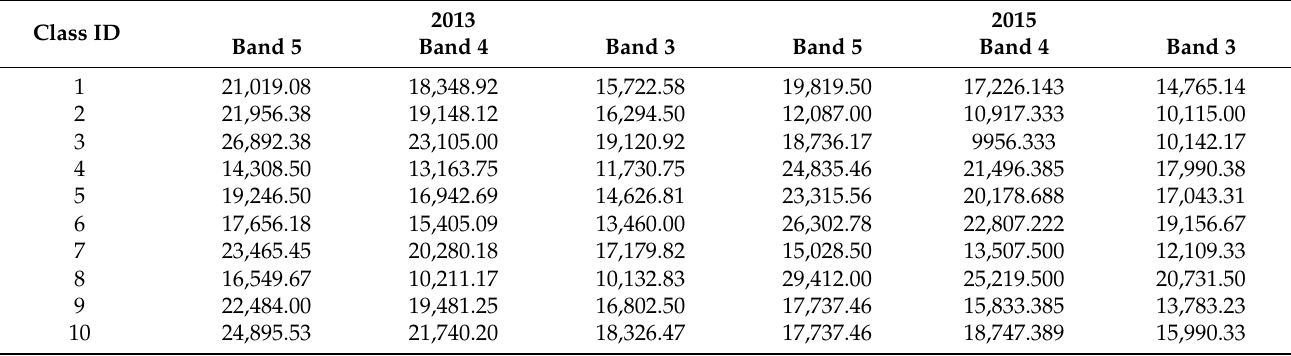
Table 3. Pairwise comparison of the k-means classification for Bands 5-4-3 of the Landsat-8 OLI/TIRS images for 2013 and 2015 in Qena Bend region 1 .